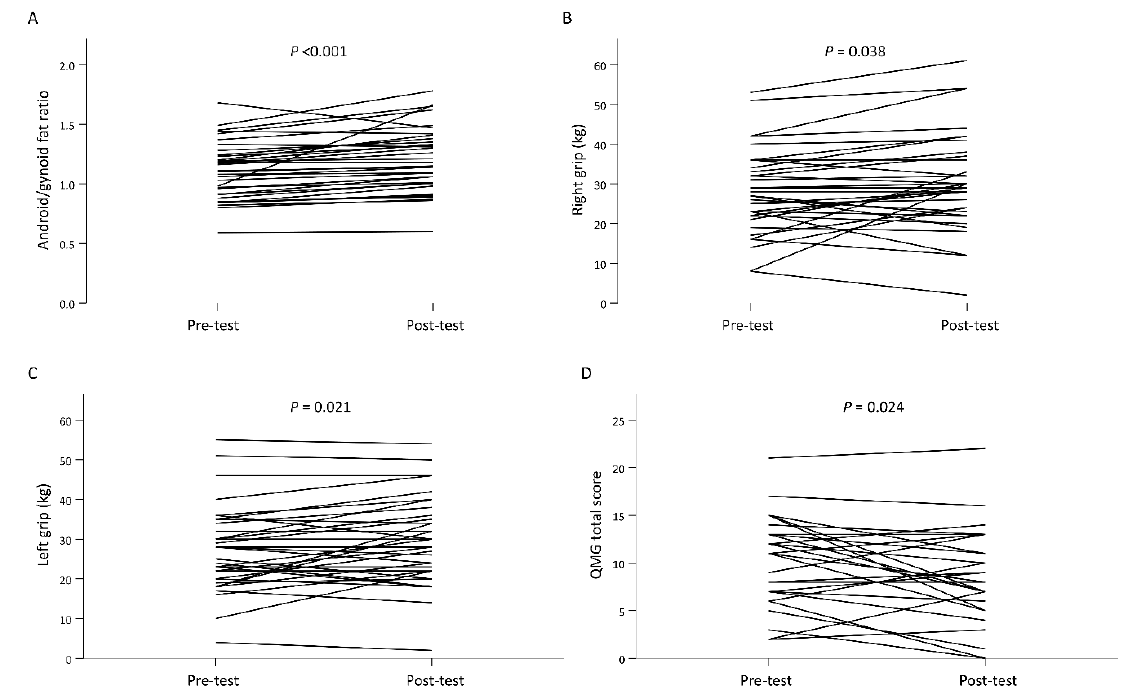
Figure 1. The individual data of android/gynoid fat ratio ( A ), right handgrip strength ( B ), left handgrip strength ( C ) and QMG total score ( D ) from the baseline to the end of the 24-week training period. QMG, quantitative myasthenia gravis.